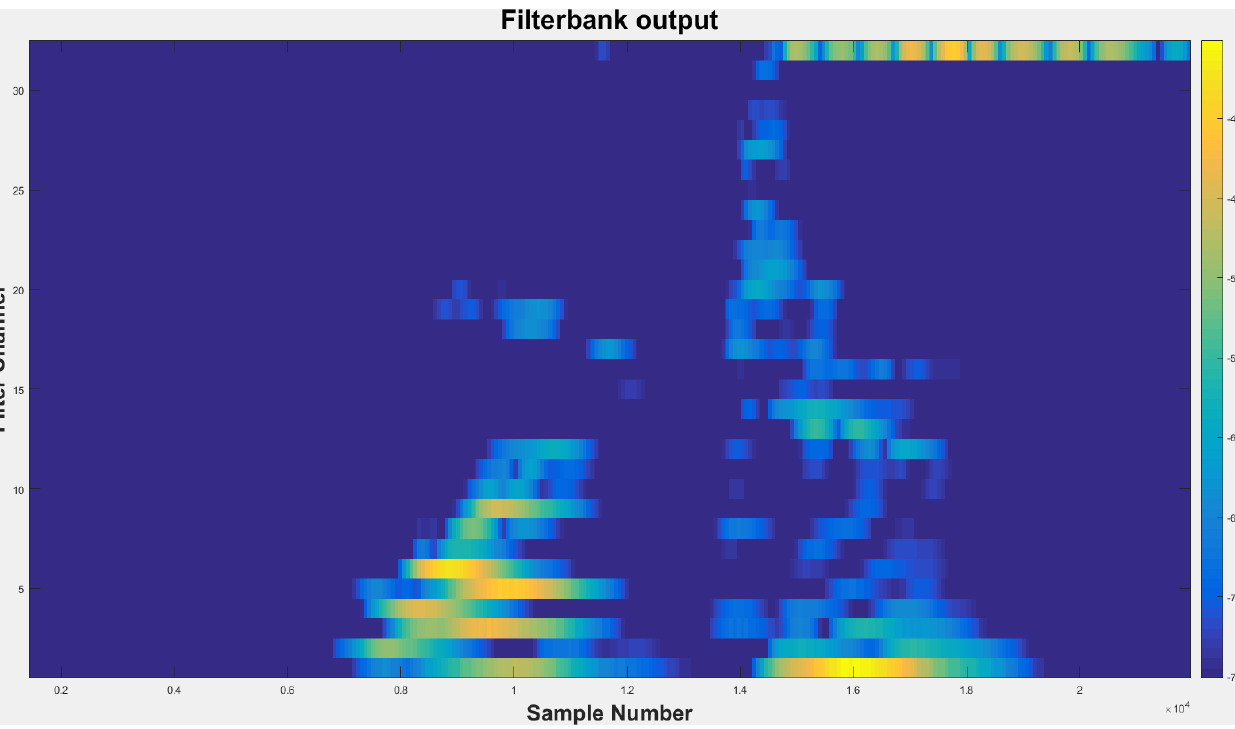
Figure 5. The output of mel-frequency filter-banks.